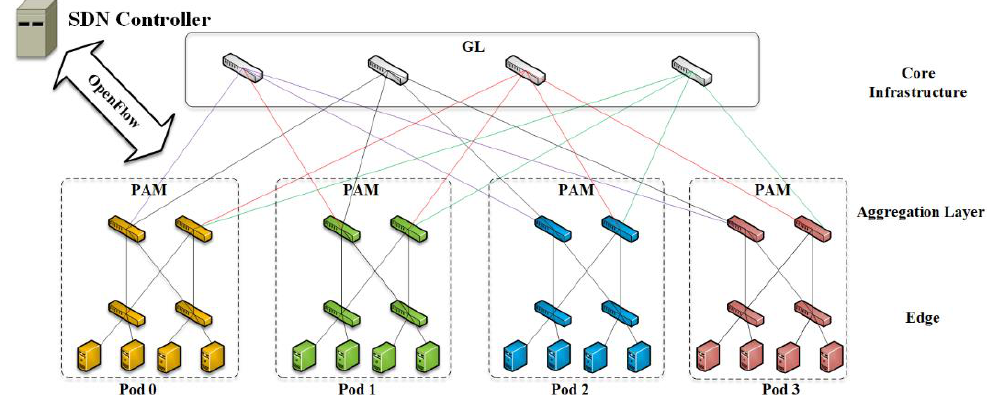
Figure 7. OpenFlow based on fat-tree.